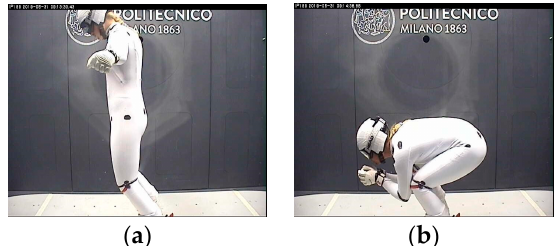
Figure 1. Images of the standing ( a ) and tuck ( b ) positions taken from the side-view camera during the PoliMi